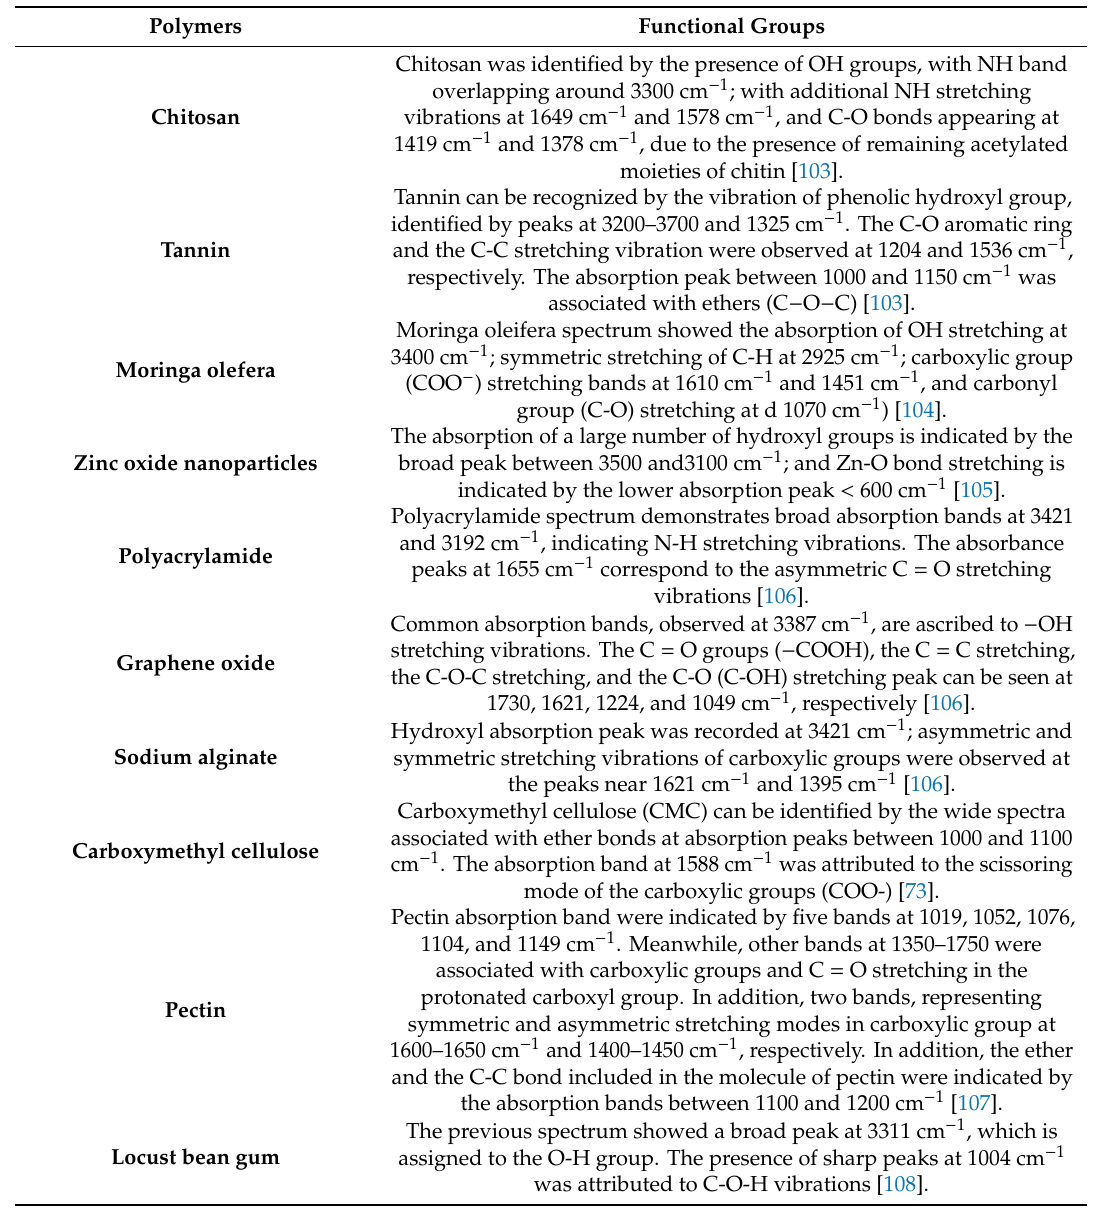
Table 7. Summary of the functional groups on selected